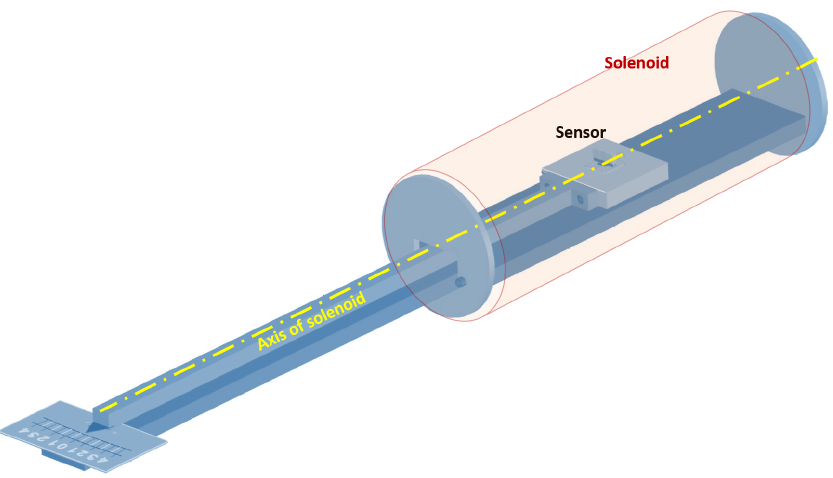
Figure 9. Representation of the support for the measurements performed at different angles of